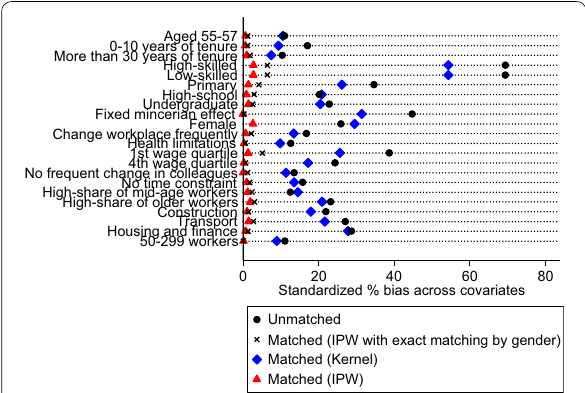
Fig. 4 Standardized differences in means of covariates between trained and non‑trained individuals without and with different matching techniques. Source: COI survey 2006/INSEE‑DARES‑CEE. Coverage: Workers aged 45–57 years old with at least 1 year of senior‑ ity and employed in firms with 20 workers or more. Note: Treated individuals are workers who participate in a training session on new ICT tools in 2006. We plot standardized biases without matching (black circles) and with different matching techniques (black crosses for IPW with exact matching by gender, blue diamonds for Kernel matching and red triangles for IPW matching). We report only covari‑ ates for which standardized bias without matching is > 10